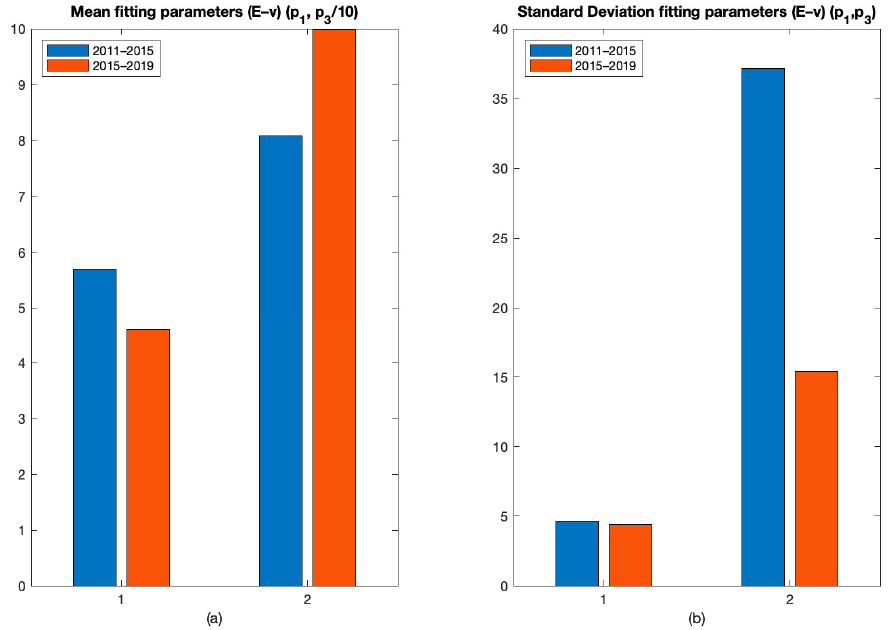
Figure 14. Fitting parameters of the entropy–velocity dispersions in the two periods for a building complex near San Giovanni station: ( a ) parameters of the mean model; ( b ) parameters of the stand- ard deviation model.